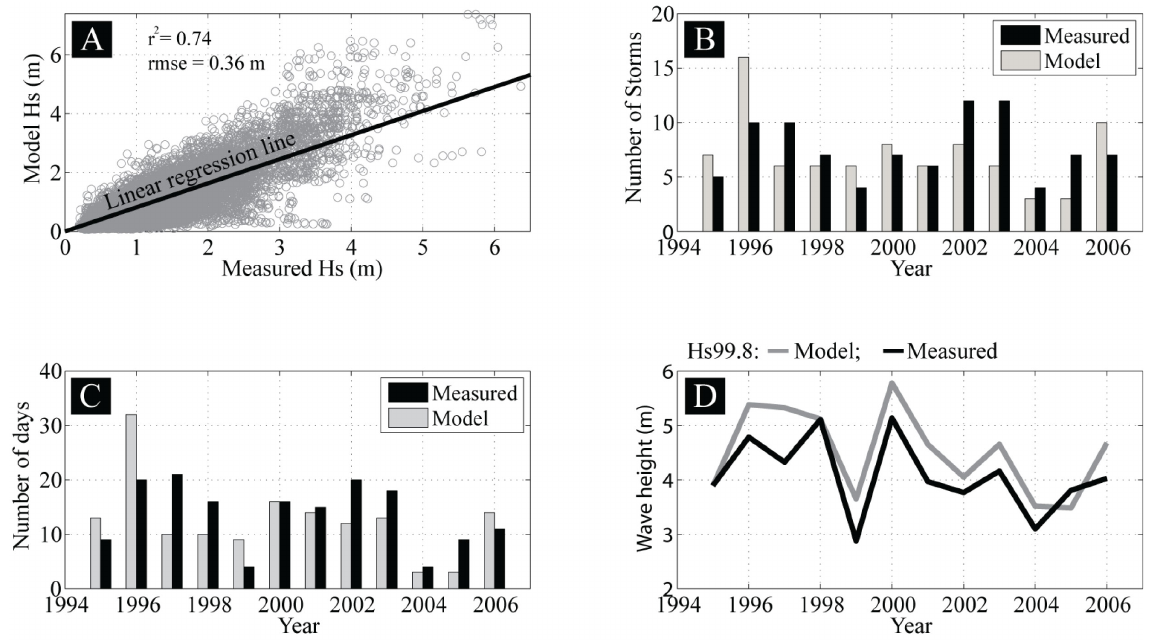
Fig. 2. Model validation results; (A) linear regression between model and measured data; (B) comparison of the annual number of storms between model and measurements; (C) comparison of the annual number of days with storms between model and measurements; (D) com- parison of annual 99.8 percentile between model and